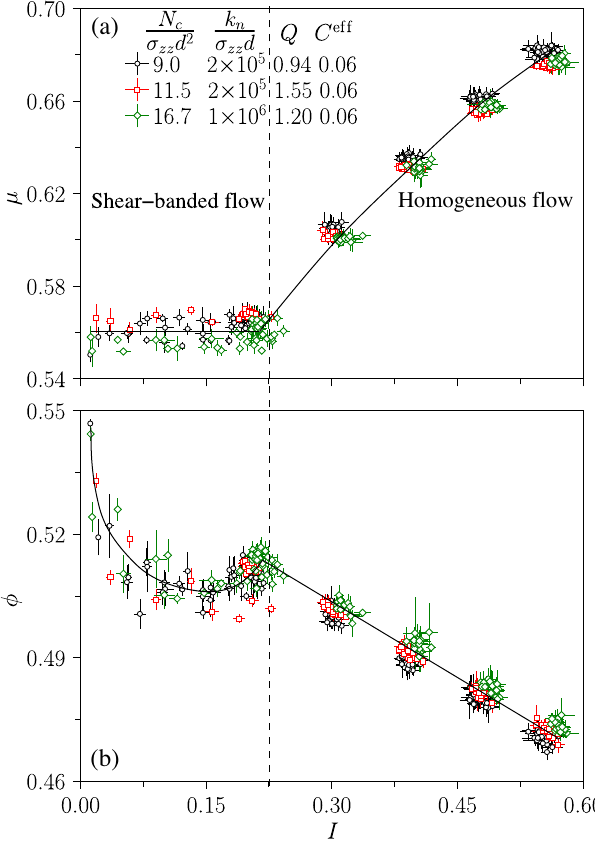
FIG. 2. Typical flow curves. Variation of (a) the friction coefficient μ and (b) the volume fraction ϕ with the inertial number I for “ effective ” cohesion number C eff ¼ 0 . 06 for three different sets of model parameters ð N c ; k n ; Q Þ . Data are obtained using n ¼ 12 000 grains during the steady shear rate up sweep. Error bars show the standard deviations over four sets. The solid lines are guides to the eye. The dashed line, corresponding to a critical inertial number I c , demarcates the regime of steady, homogeneous flows from the regime of shear-banded flows.